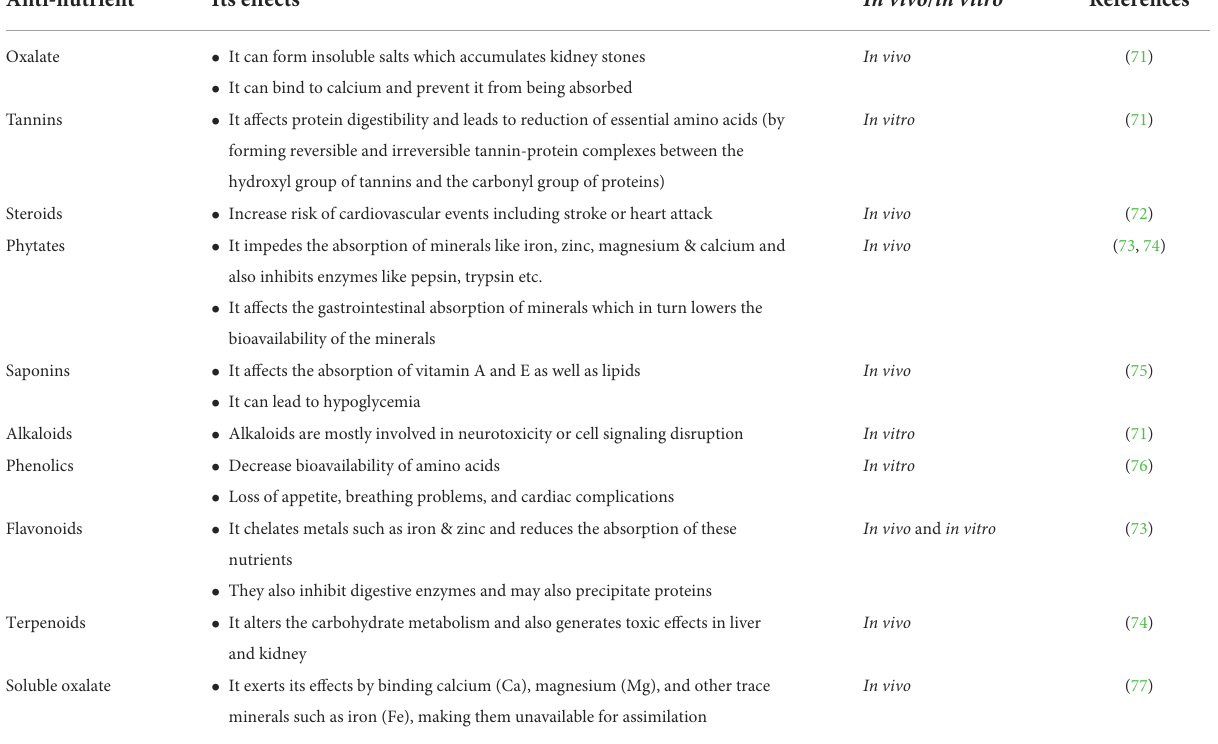
TABLE 2 List of anti-nutrients found in herbal tea and its